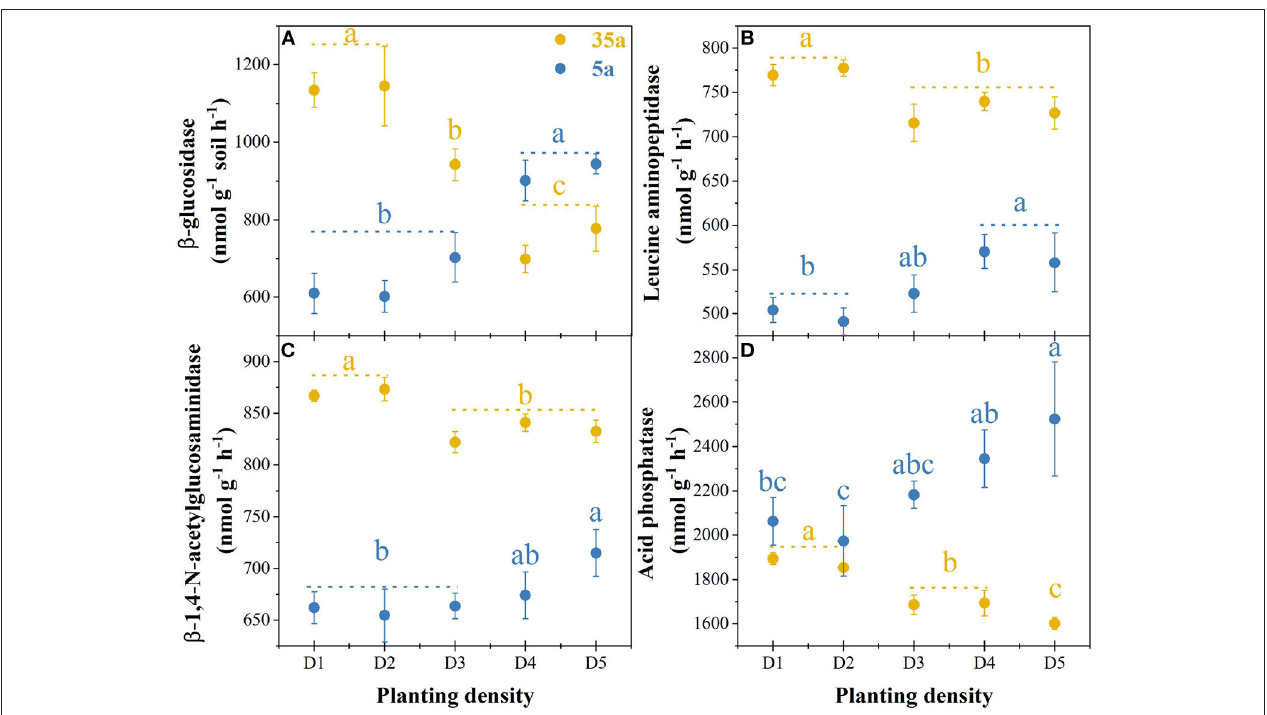
FIGURE 1 | Enzyme activities in 5-year-old (5a, blue) and 35-year-old (35a, yellow) plantations. Different lowercase letters represent significant differences between different planting densities ( p < 0.05). The data are shown as the mean ± standard deviations ( n = 3). D1, 1,667 stems ha − 1 ; D2, 3,333 stems ha − 1 ; D3, 5,000 stems ha − 1 ; D4, 6,667 stems ha − 1 ; D5, 10,000 stems ha − 1